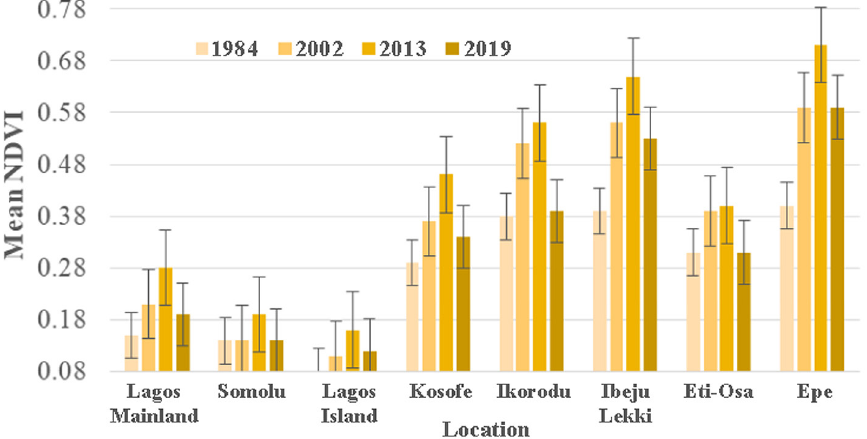
Fig. 9. Mean NDVIs associated with the eight LGAs.